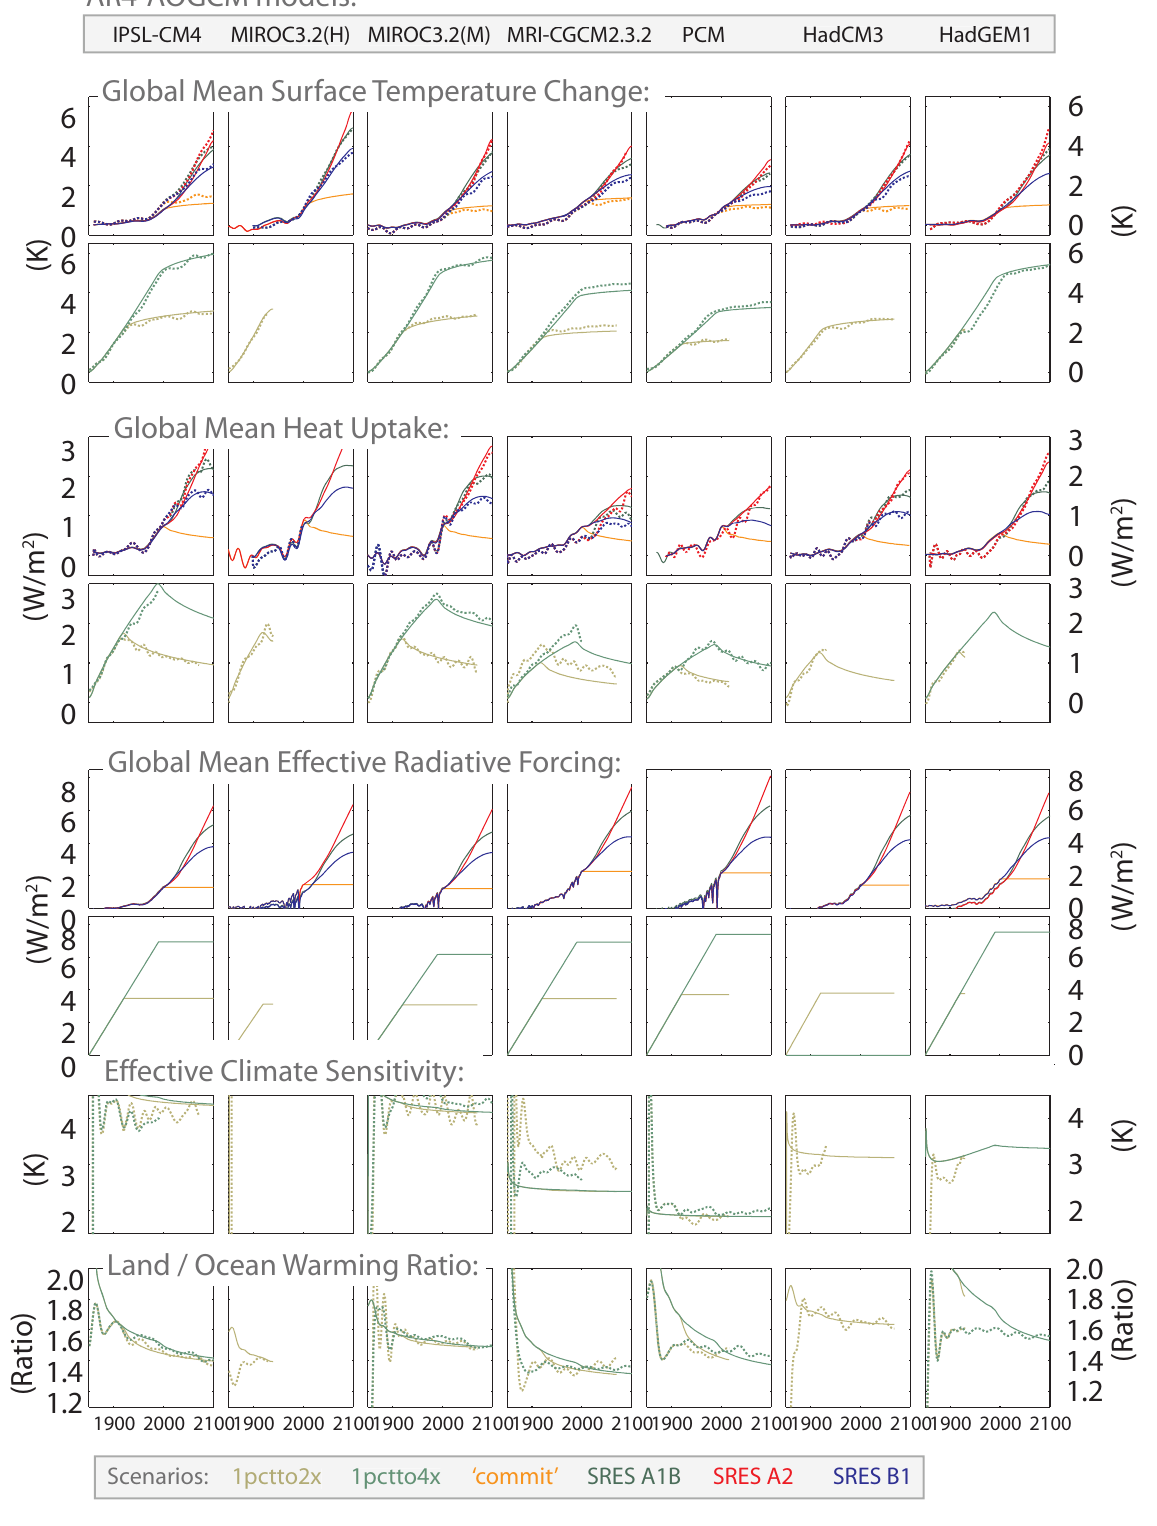
Fig. B3. As Fig. B1, but for another seven of the 19 emulated CMIP3 AOGCMs.